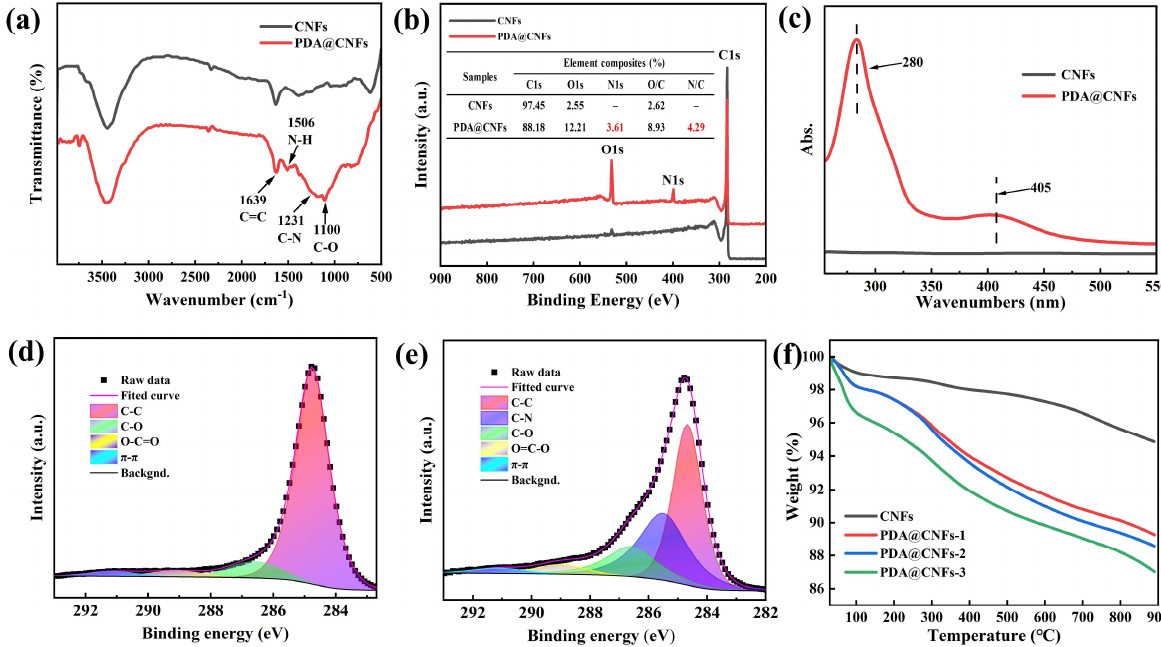
Figure 3. ( a ) FT-IR spectra of CNFs and PDA@CNFs, ( b ) XPS full scanning spectra and the element content of the nanofillers, ( c ) UV-VIS spectra of PDA@CNFs and CNFs, C1s spectra of ( d ) CNFs and